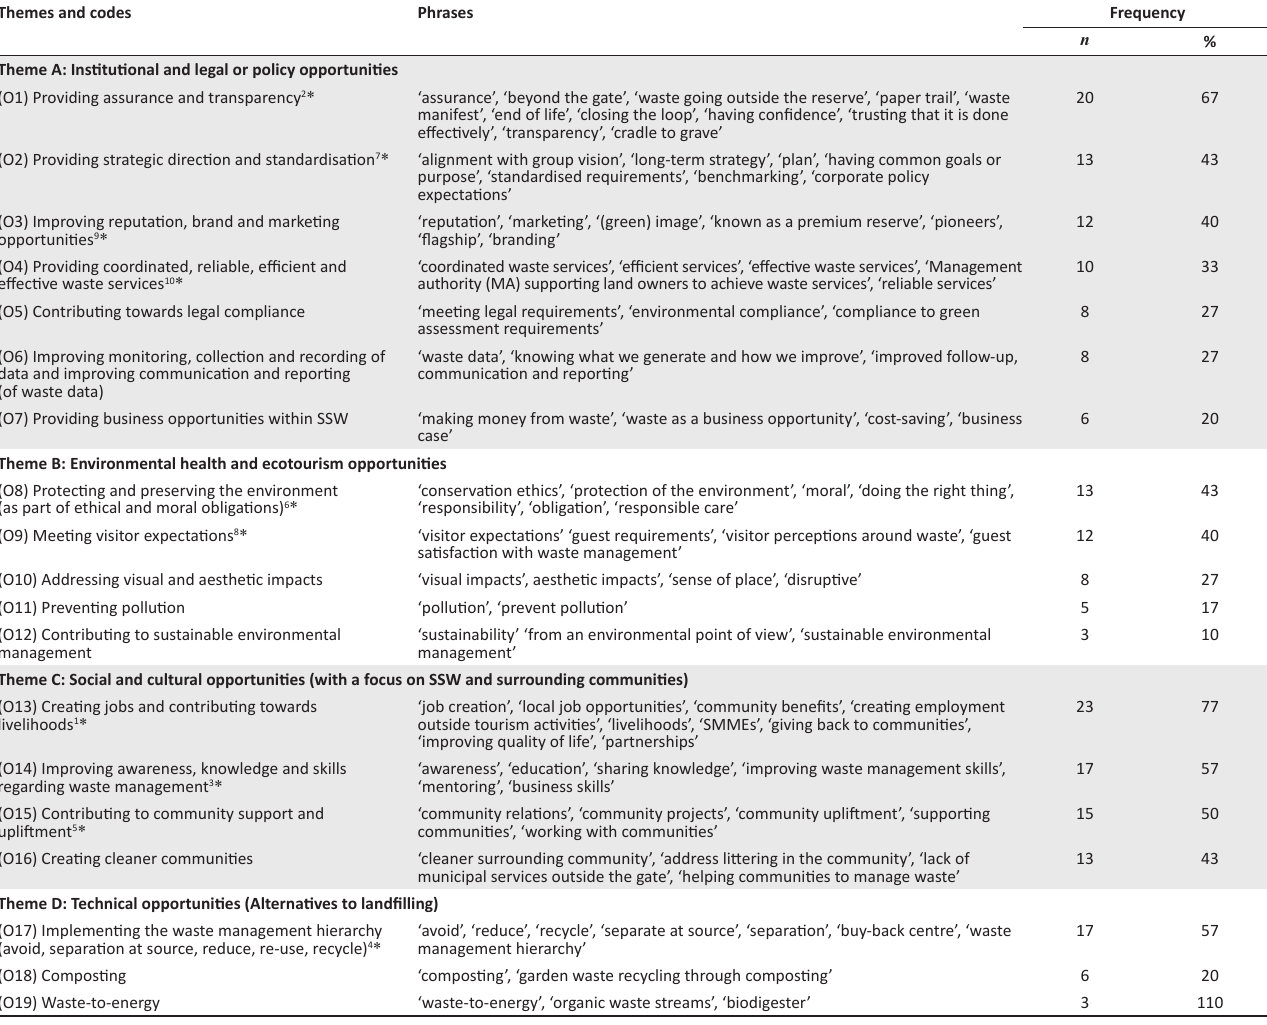
TABLE 2: The number (and percentage out of a total of 30 participants) of responses per code as it relates to the perceived opportunities for sustainable solid waste management in the private nature reserve. Themes and codes Theme A: Institutional and legal or policy opportunities